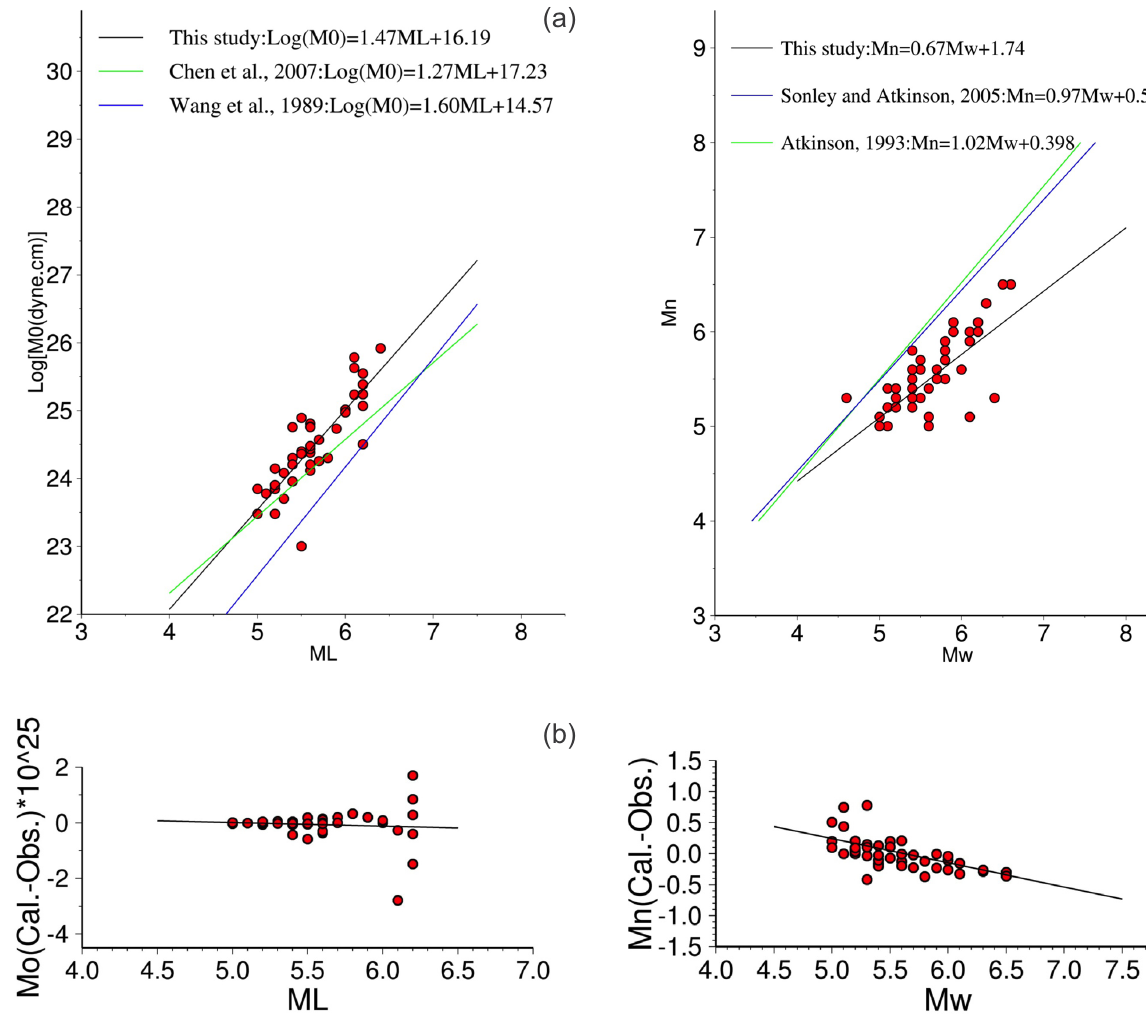
Figure 4. (a) Scatter plot of Log parisons of the conversion models with different studies in the lit- erature. (b) Residual diagram for evaluating Figure 4a.